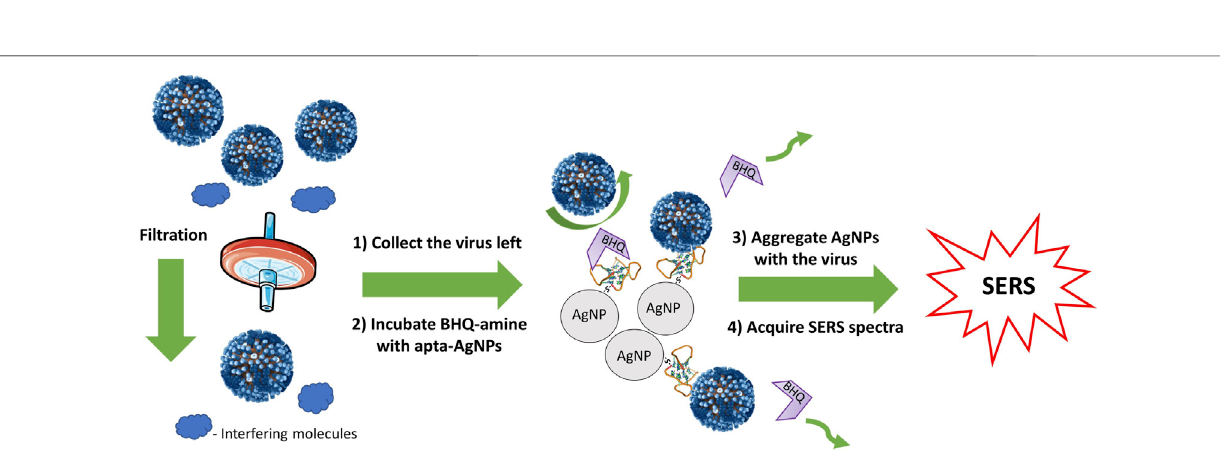
Frontiers in Chemistry |